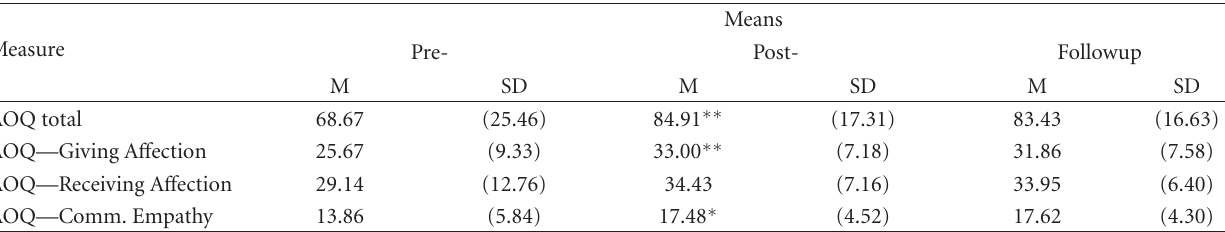
Table 2: Means scores on the AOQ by testing time.